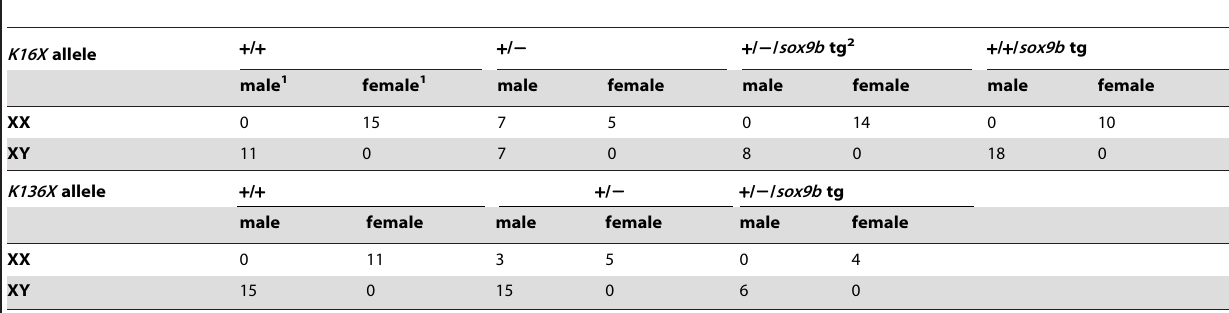
Table 1. Sox9b mutations lead to a discordance between the genetic and phenotypic sex in the